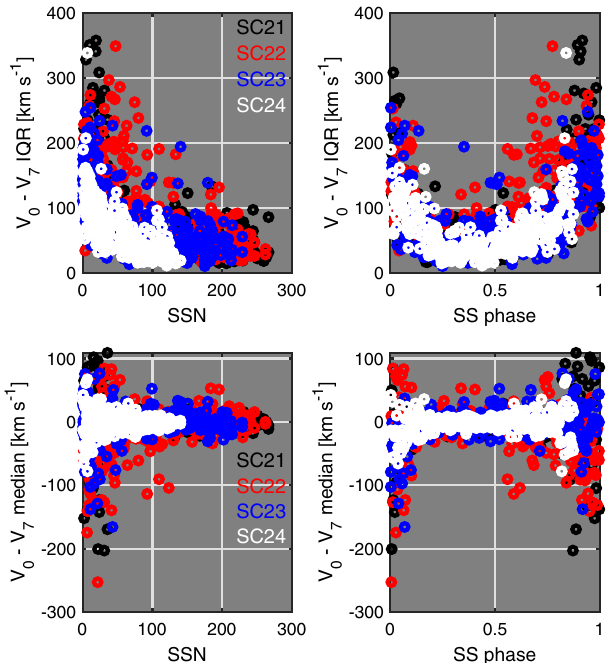
Fig. 5. Scatter plots of 1-CR averages of V 0 (cid:3) V 7 , the solar wind speed difference between the equator and 7 (cid:1) latitude, with solar activity. Top: the inter-quartile range of V 0 (cid:3) V 7 as a function of sunspot number (left) and sunspot cycle phase (right), where solar minimum is 0 and 1, and solar maximum is approximately 0.5. Bottom: the median of V 0 (cid:3) V 7 as a function of sunspot number (left) and sunspot cycle phase (right). In all panels, solar cycles 21, 22, 23, and 24 have been coloured black, red, blue, and white,